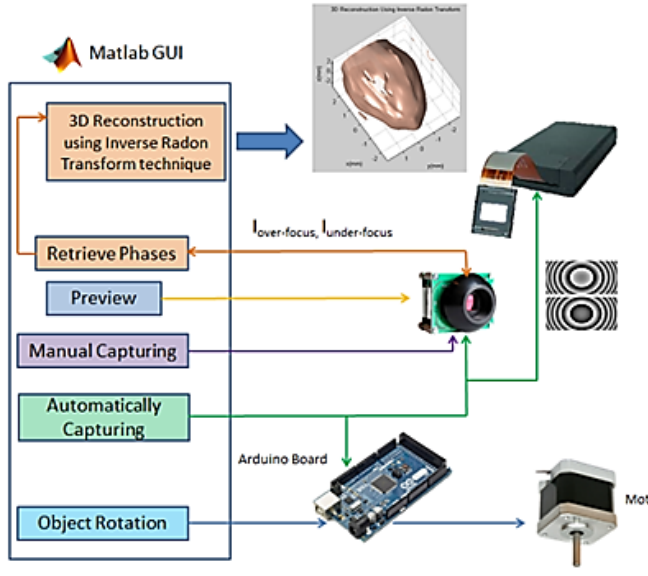
Figure 13. Block diagram of the recording and reconstruction process.